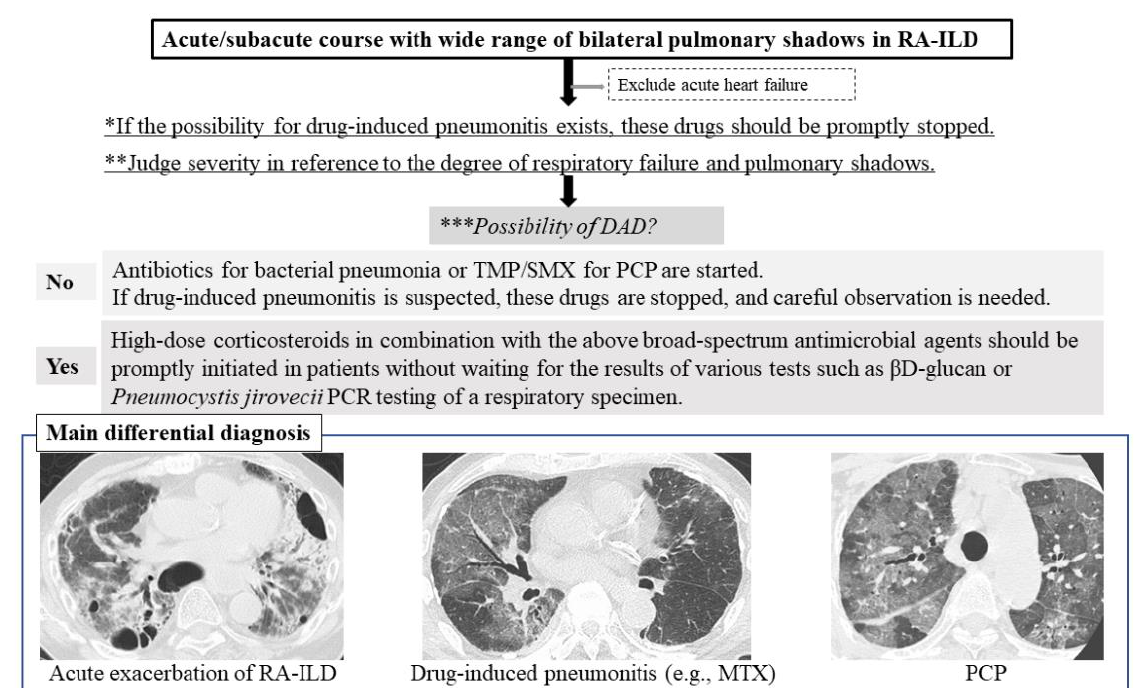
Figure 1. Three differential diagnoses of the acute/subacute course of RA-ILD are acute exacerbation of RA-ILD, drug- induced pneumonitis, and PCP. Abbreviations: DAD = diffuse alveolar damage; MTX = methotrexate; PCP = Pneumocystis pneumonia; RA-ILD = rheumatoid arthritis-associated interstitial lung disease; TMP/SMX = trimethoprim/sulfamethoxazole. Flow chart. First*, if the possibility of drug-induced pneumonitis exists, the drugs treating RA should be stopped promptly. Second, clinicians should judge severity** and the possibility of DAD***.